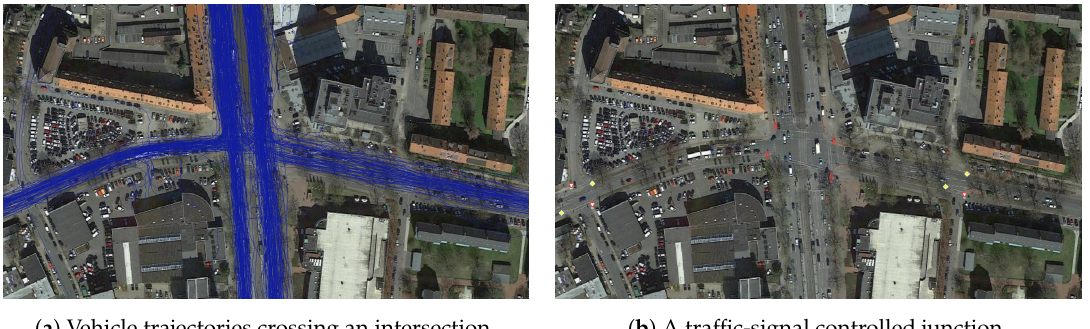
Figure 2. From crowdsourced data ( a ) to traffic regulator detection and recognition ( b